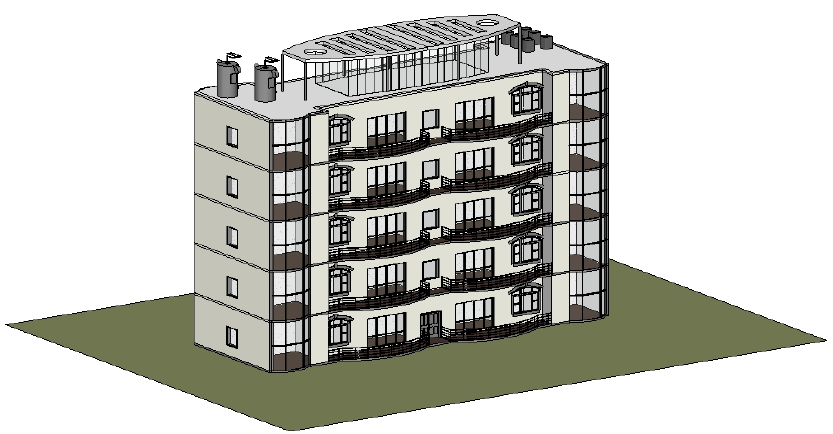
Figure 9. Model of the residential building.